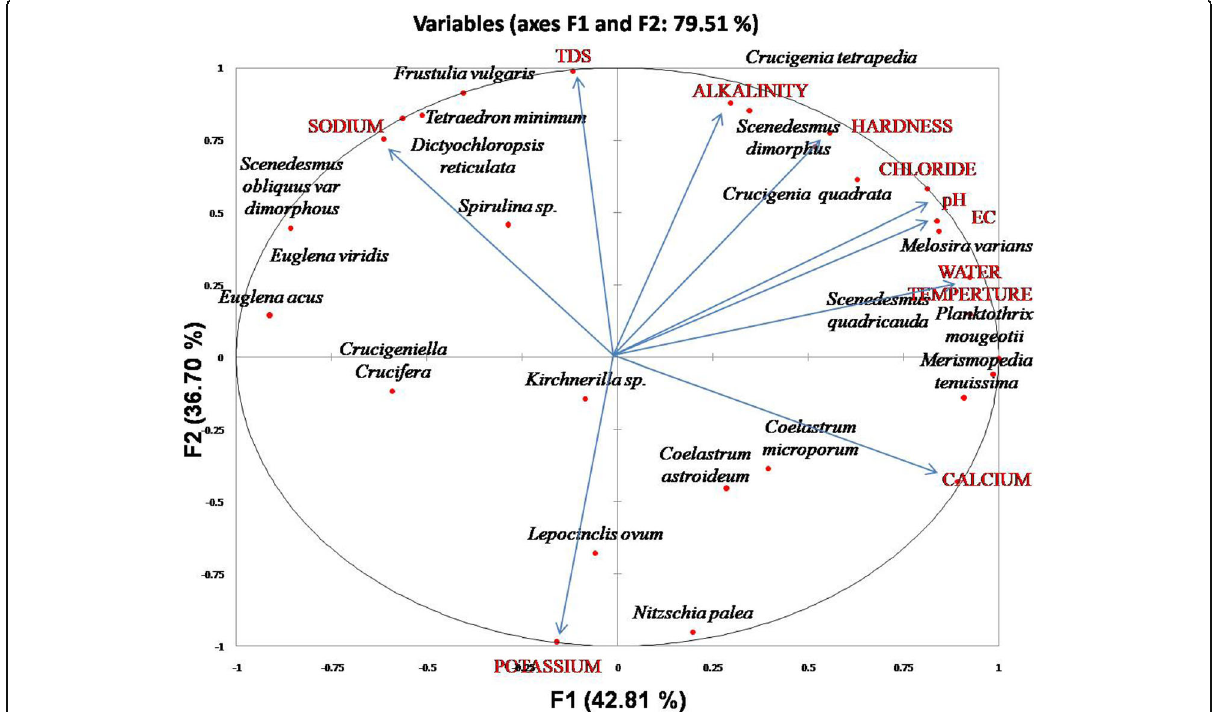
Fig. 5 Principal Component Analysis of physico-chemical parameters and dominant species of Prithus Pool